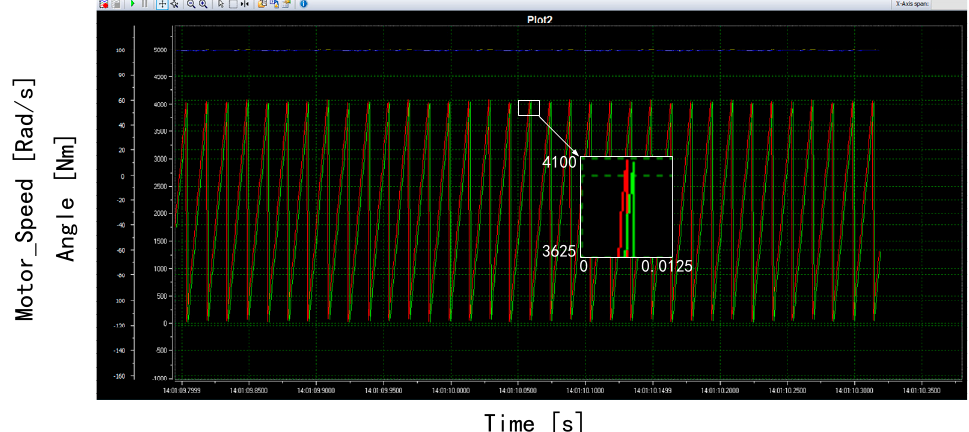
Figure 24. The comparison chart of the motor speed and rotor position of the new and improved SMO observer at 100 rad/s.